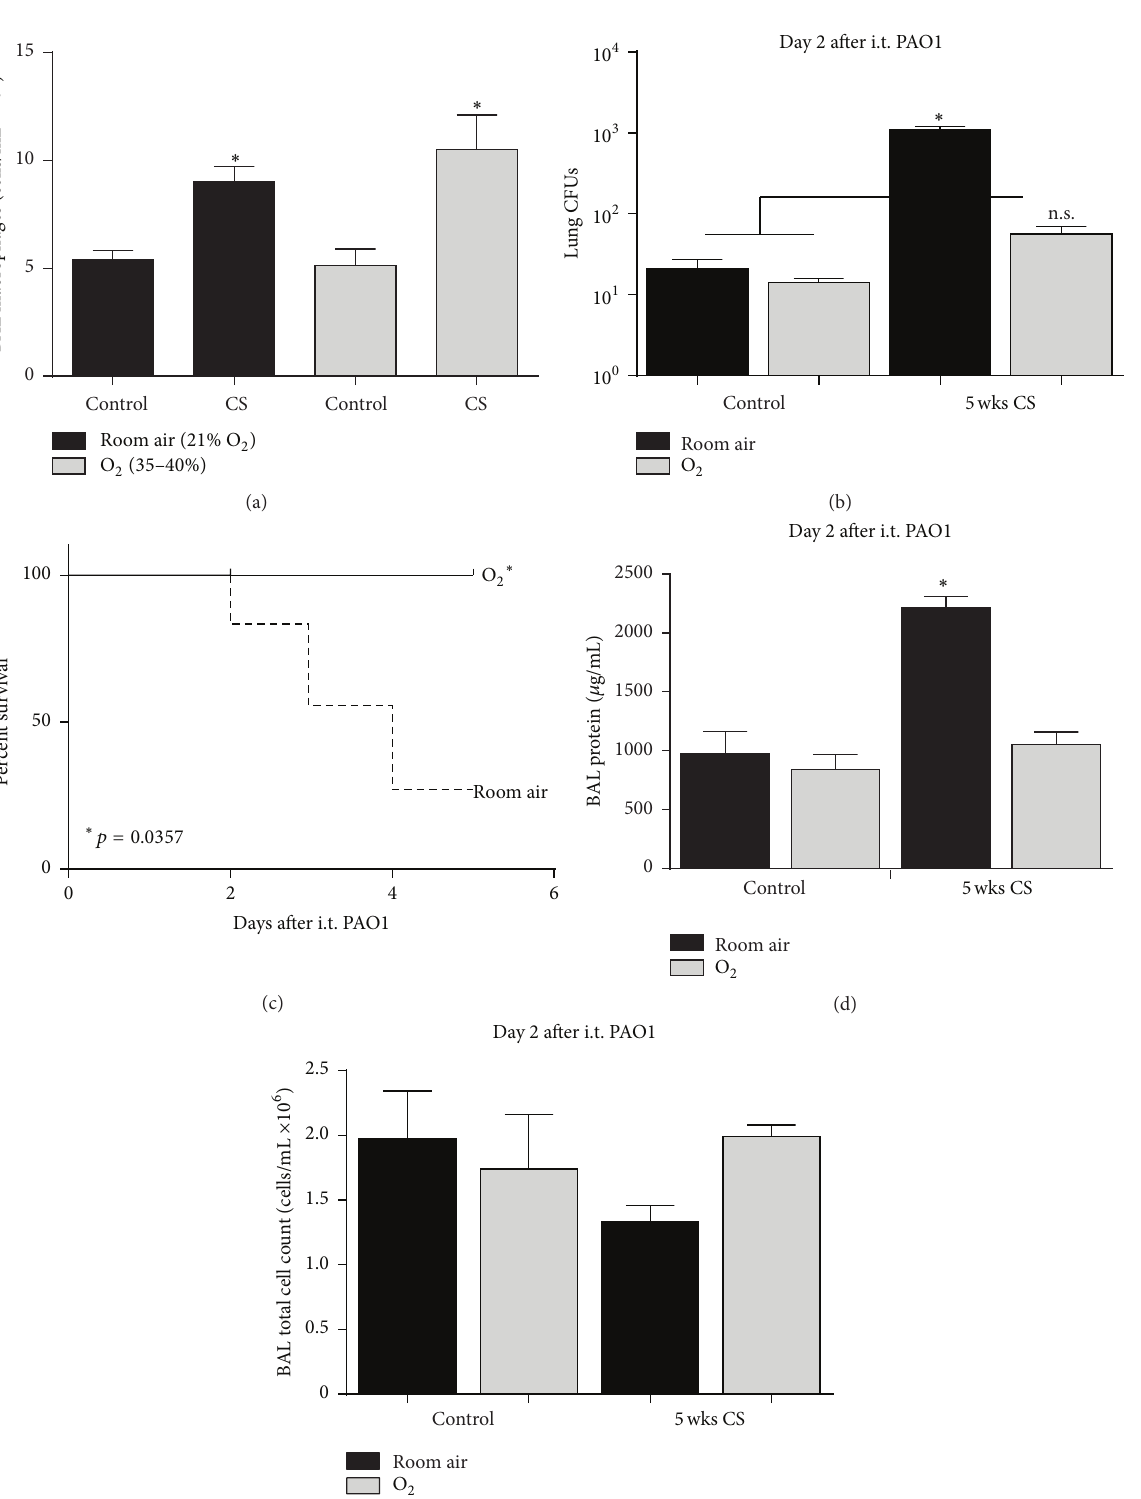
Figure 1: Low-dose oxygen is beneficial in CS- and PAO1-exposed mice. (a) Macrophages recovered by BAL from mice exposed to 5 weeks of cigarette smoke followed by 35–40% oxygen or room air for an additional 3 days ( 𝑛 = 4 -5, ∗ 𝑝 < 0.05 by one-way ANOVA). (b–d) Following 5-week CS or room air exposure, mice were exposed to PAO1 bacteria by intratracheal (i.t.) injection and either low-dose oxygen (35–40%) or room air (control), followed by up to 5 days of oxygen or room air exposure. (b) At day 2 after PAO1 exposure, mice were harvested and lung CFUs were quantified ( 𝑛 = 2 -3, ∗ 𝑝 < 0.001 against all other groups by one-way ANOVA, and n.s. compared to both control groups). (c) Among CS-exposed mice, Kaplan-Meier survival curve following i.t. PAO1 exposure ( 𝑛 = 6 -7 mice, 𝑝 = 0.0357 by log-rank Mantel-Cox). (d) Following bronchoalveolar lavage (BAL) on day 2 after PAO1 exposure, total protein was quantified ( 𝑛 = 2 –4, ∗ 𝑝 < 0.01 against all other groups by one-way ANOVA). (e) Following day 2 BAL, total cell count was quantified ( 𝑛 = 2